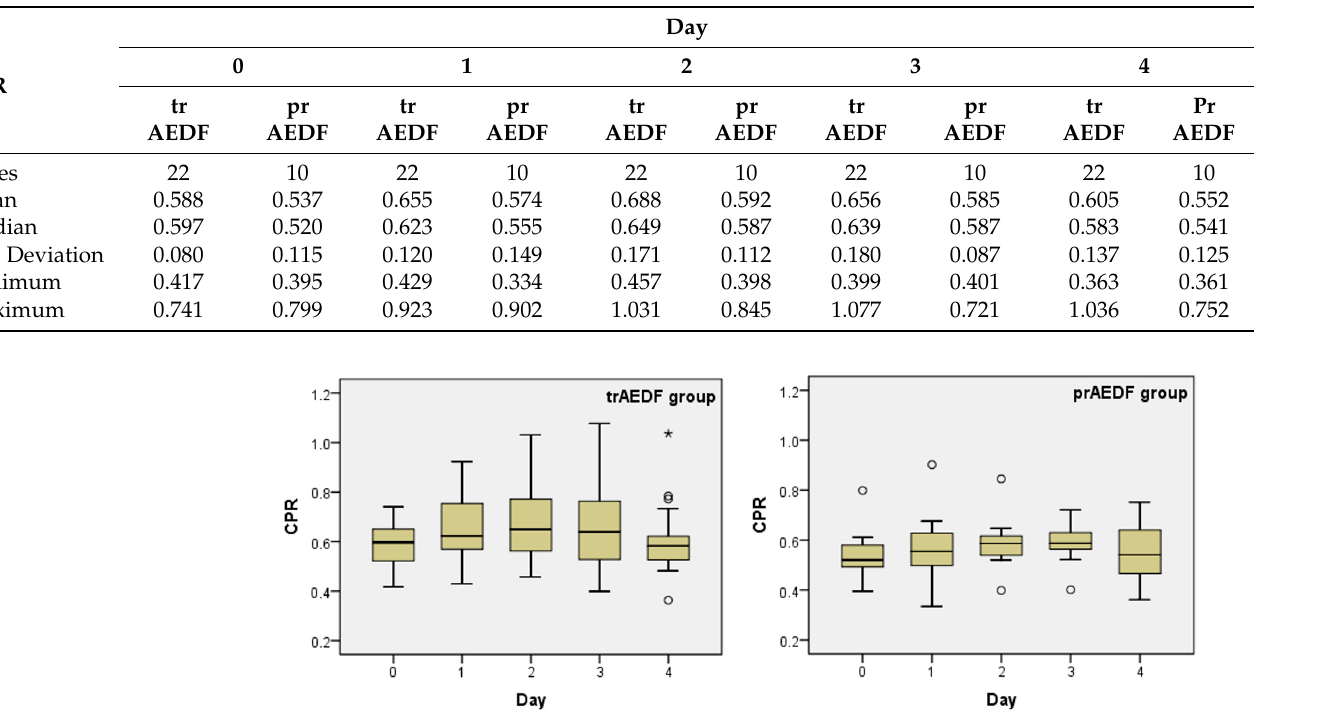
Figure 2. Boxplot charts on the pulsatility index’s evolution in the middle cerebral artery (MCA ‐ PI), prior (day 0) and in the first 4 days after maternal dexamethasone administration, in the two groups (tr/prAEDF = transiently restored/persistent absent end ‐ diastolic flow in umbilical artery group). CPR was subunitary in all fetuses at recruitment (Table 5; Figure 3). Table 5. The characteristics of the cerebroplacental ratio (CPR) prior (day 0) and in the first 4 days after maternal dexamethasone administration in the two groups. (tr/prAEDF = transiently re- stored/persistent absent end-diastolic flow in umbilical artery group).